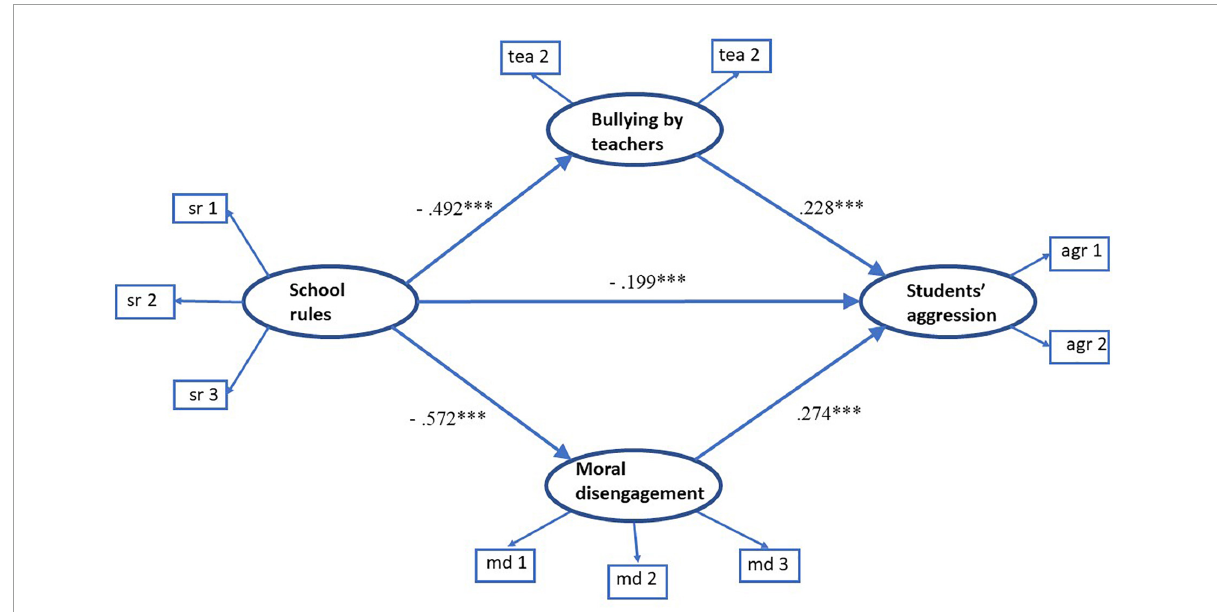
FIGURE2 Structural equation model of school disciplinary structure and peer aggression, mediated by bullying by teachers and moral disengagement. The coefficients represent standardized parameter estimates. ∗∗∗ p <